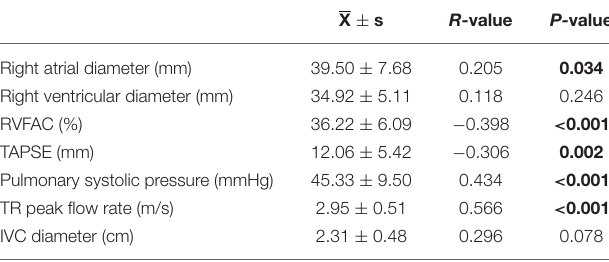
TABLE 5 | Spearman correlation analysis of liver elasticity value with right heart function parameters.